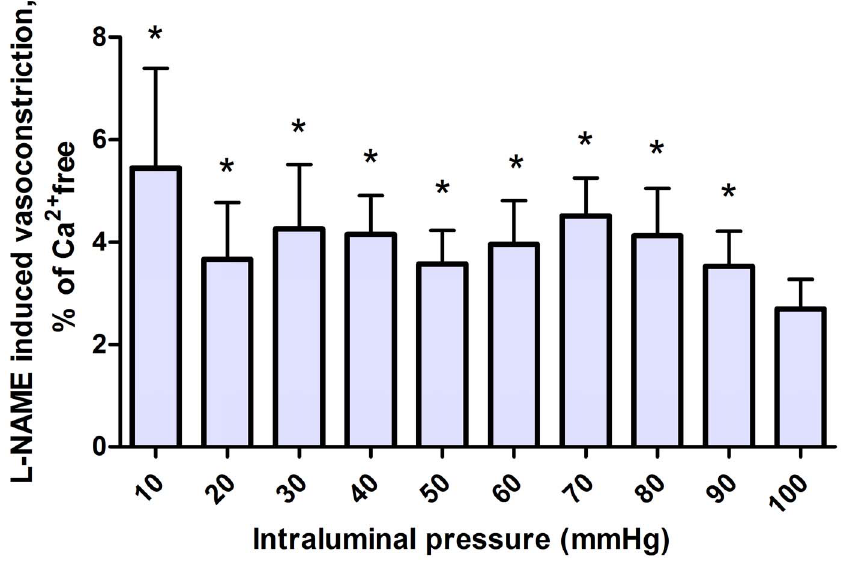
Figure 6. Vasoconstriction induced by L-NAME in coronary arteriole segments pretreated with quercetin and indomethacin. Concentrations: L-NAME: 10 2 4 moles/lit, quercetin: 10 2 7 moles/lit, and indomethacin: 10 2 5 moles/lit. * p , 0.05 with